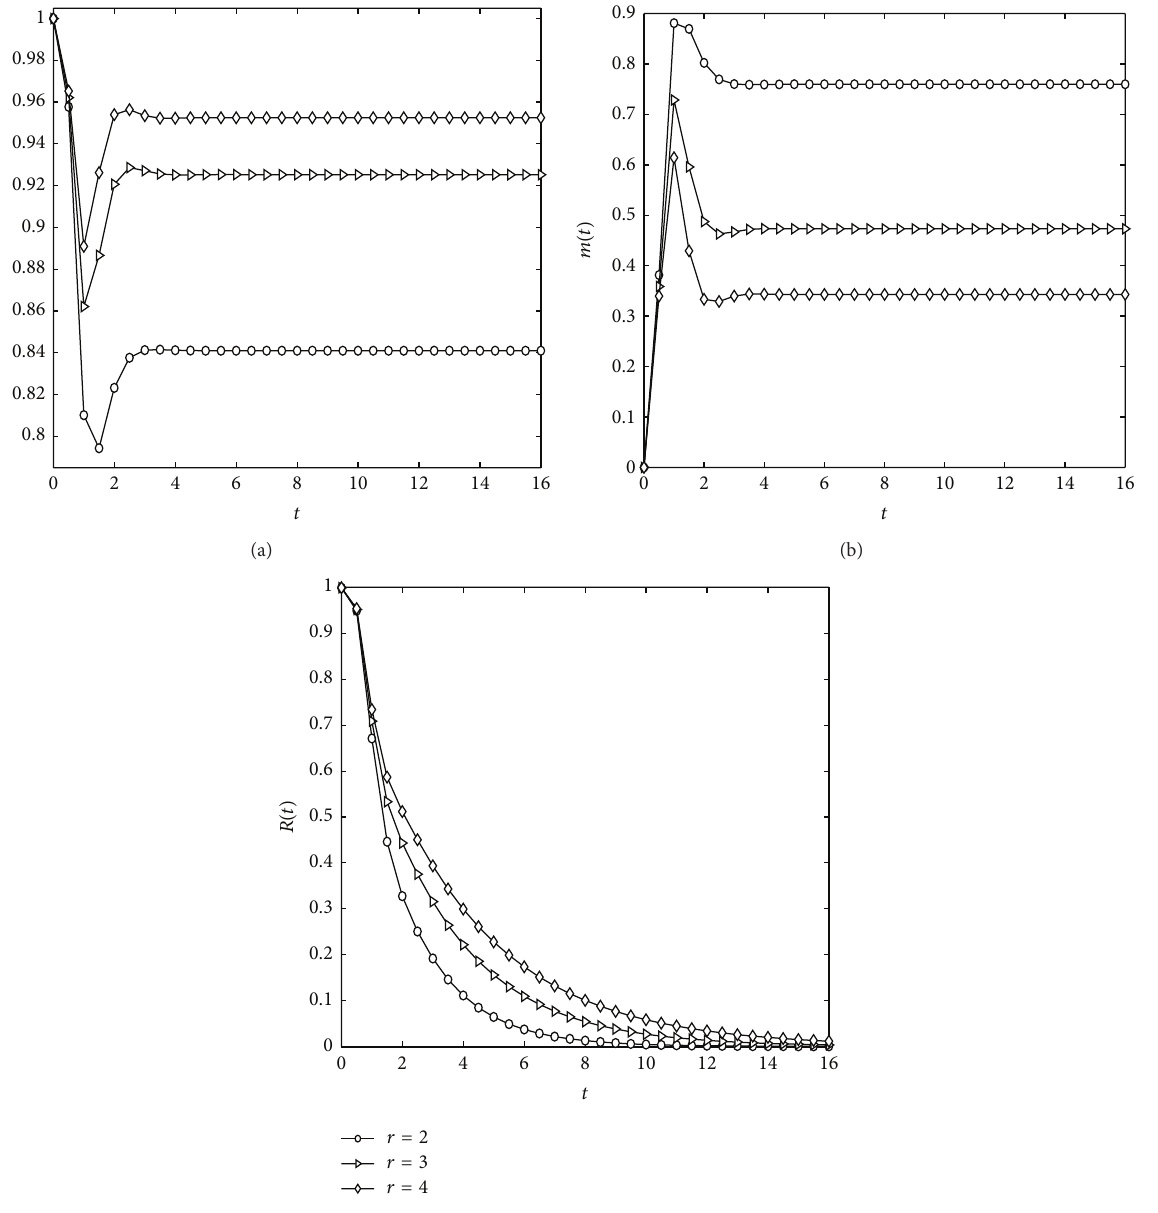
The expected values of the above three PH distributions are 0.1926, 1.3500, and 3.3333, respectively. The computational results for the state probabilities at time 𝑡 with Coxian vaca- tion time distribution are provided in Table 2. For the three cases, Figures 2(a)–2(c) indicate the influence of the vacation time on the three system reliability measures. We observe from Figure 2(a) that the system availability decreases with increasing the mean of vacation time. So does the system reliability. Figure 2(b) shows that the rate of occurrence of (28) failure of the system goes on increasing with